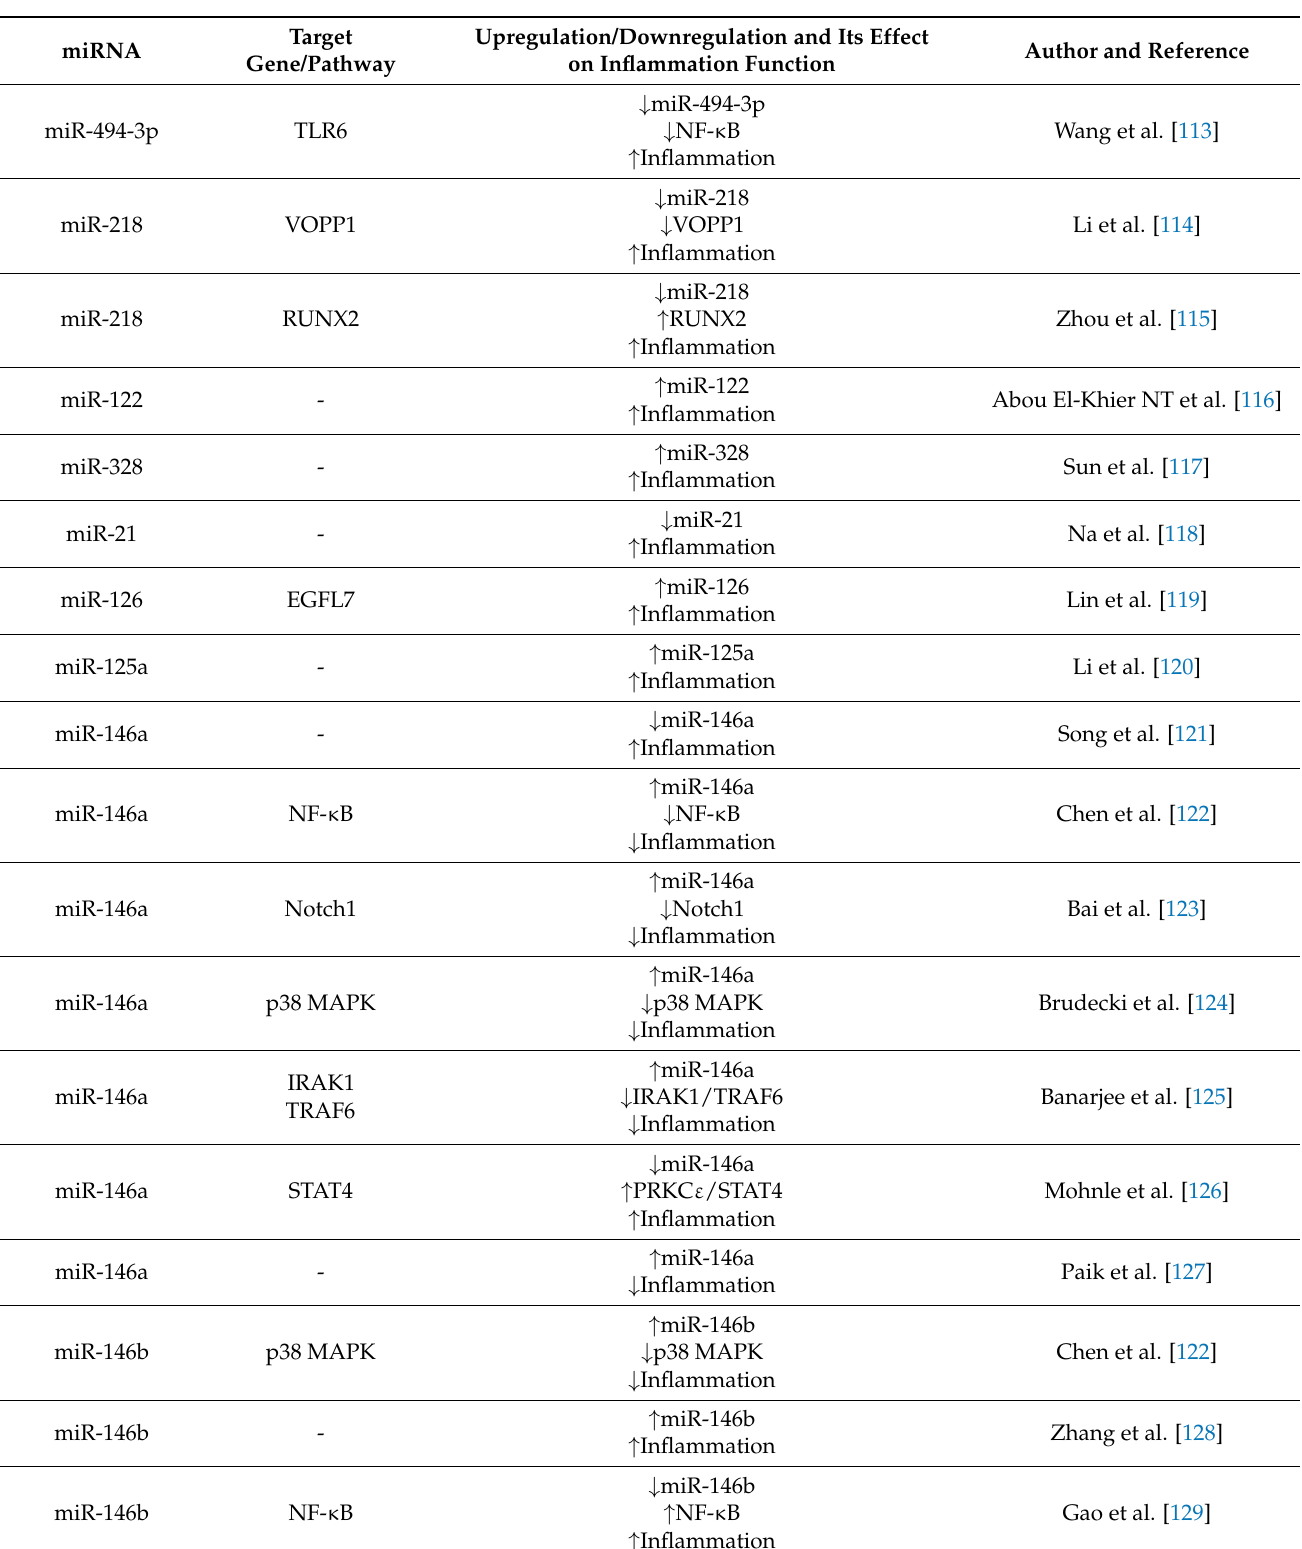
Table 9. miRNAs involved in sepsis-induced inflammation and their targets in blood. ↑ indicates up regulation, ↓ indicates down